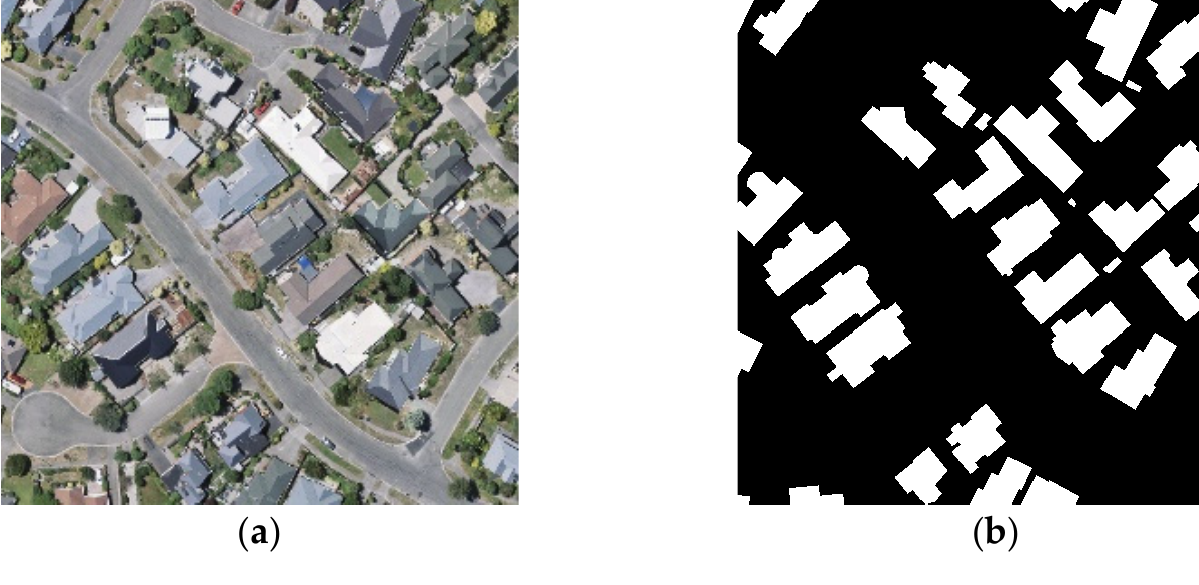
Figure 8. Image and label example selected from the WHU dataset: ( a ) Original image; ( b ) Ground truth. Black and white pixels mark non-building and building, respectively.